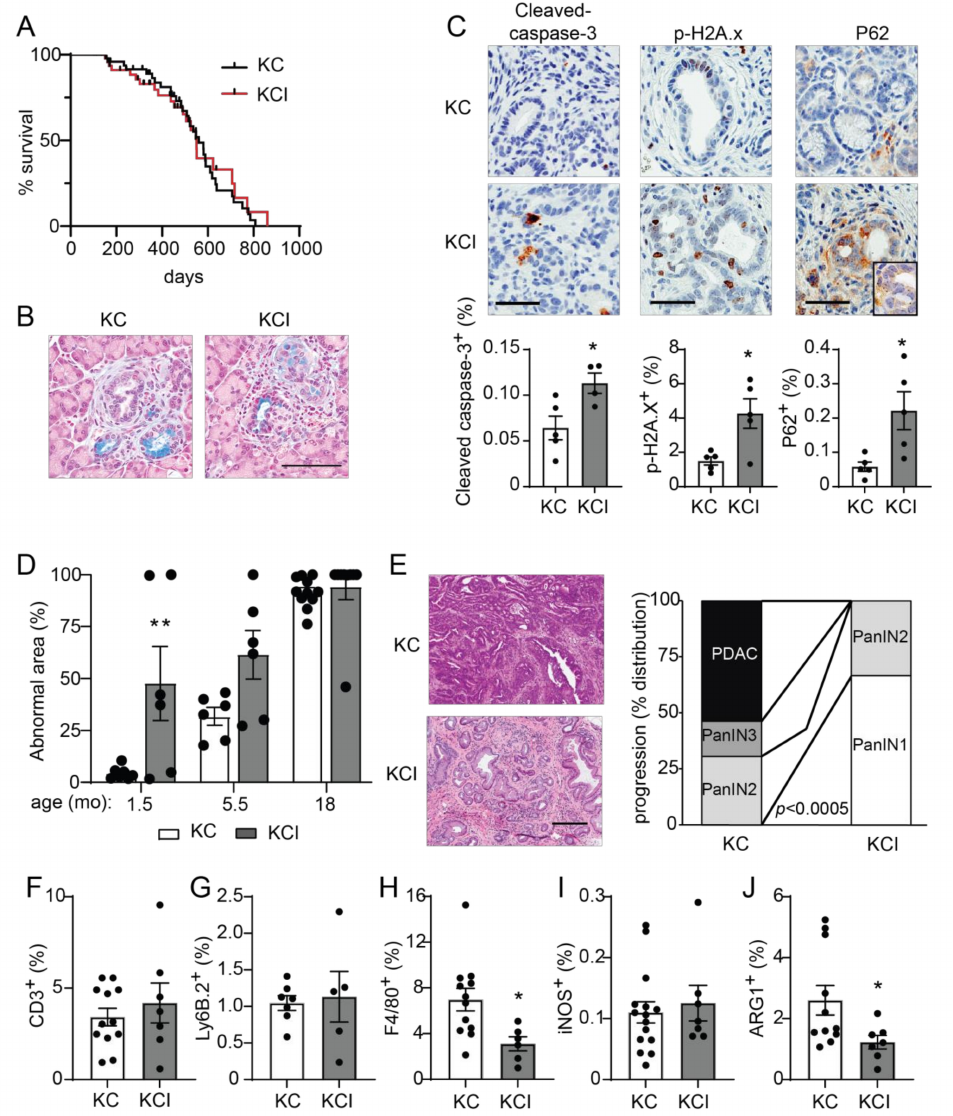
Figure 6. Pancreas-specific Prkci knockout increases early Kras G12D -mediated PanIN formation, but blocks progression to adenocarcinoma and alters immune cell infiltration. ( A ) Kaplan-Meier analysis of overall survival of KC and KCI mice ( n = 51, 50, respectively). ( B ) Representative images of Alcian blue-stained pancreas from 1.5 month old KC and KCI mice (scale bar = 100 µ m). ( C ) Representative images (top) and quantitative analysis of IHC detection (bottom) of cleaved caspase-3, p-H2A.x, and P62 aggregates in PanIN lesions of 1.5 month old KC and KCI mice, (scale bar = 50 µ m). Results plotted as mean ± SE; n = 4–5; * p < 0.05. ( D ) Quantitation of area of abnormal tissue (ADM, dysplasia, and PDAC) in KC and KCI mouse pancreas is plotted; n ≥ 6, ** p < 0.01 compared to KC . ( E ) Representative images of H&E stained pancreas from 18 month old KC and KCI mice are shown (left; scale bar = 200 µ M). Neoplastic progression of 18 month old KC and KCI mice is plotted; (right; n = 13, 9; see also Figure S7D). Quantitative analysis of IHC detection of ( F ) T cells (CD3 + ), ( G ) neutrophils (Ly6.B + ), ( H ) macrophages (F4/80 + ), ( I ) M1 polarized macrophages (iNOS + ), and ( J ) M2 polarized macrophages (ARG1 + ) in pancreatic lesions of 18 month old KC and KCI mice. IHC quantitation is plotted as mean ± SE; n = 6–15. * p <